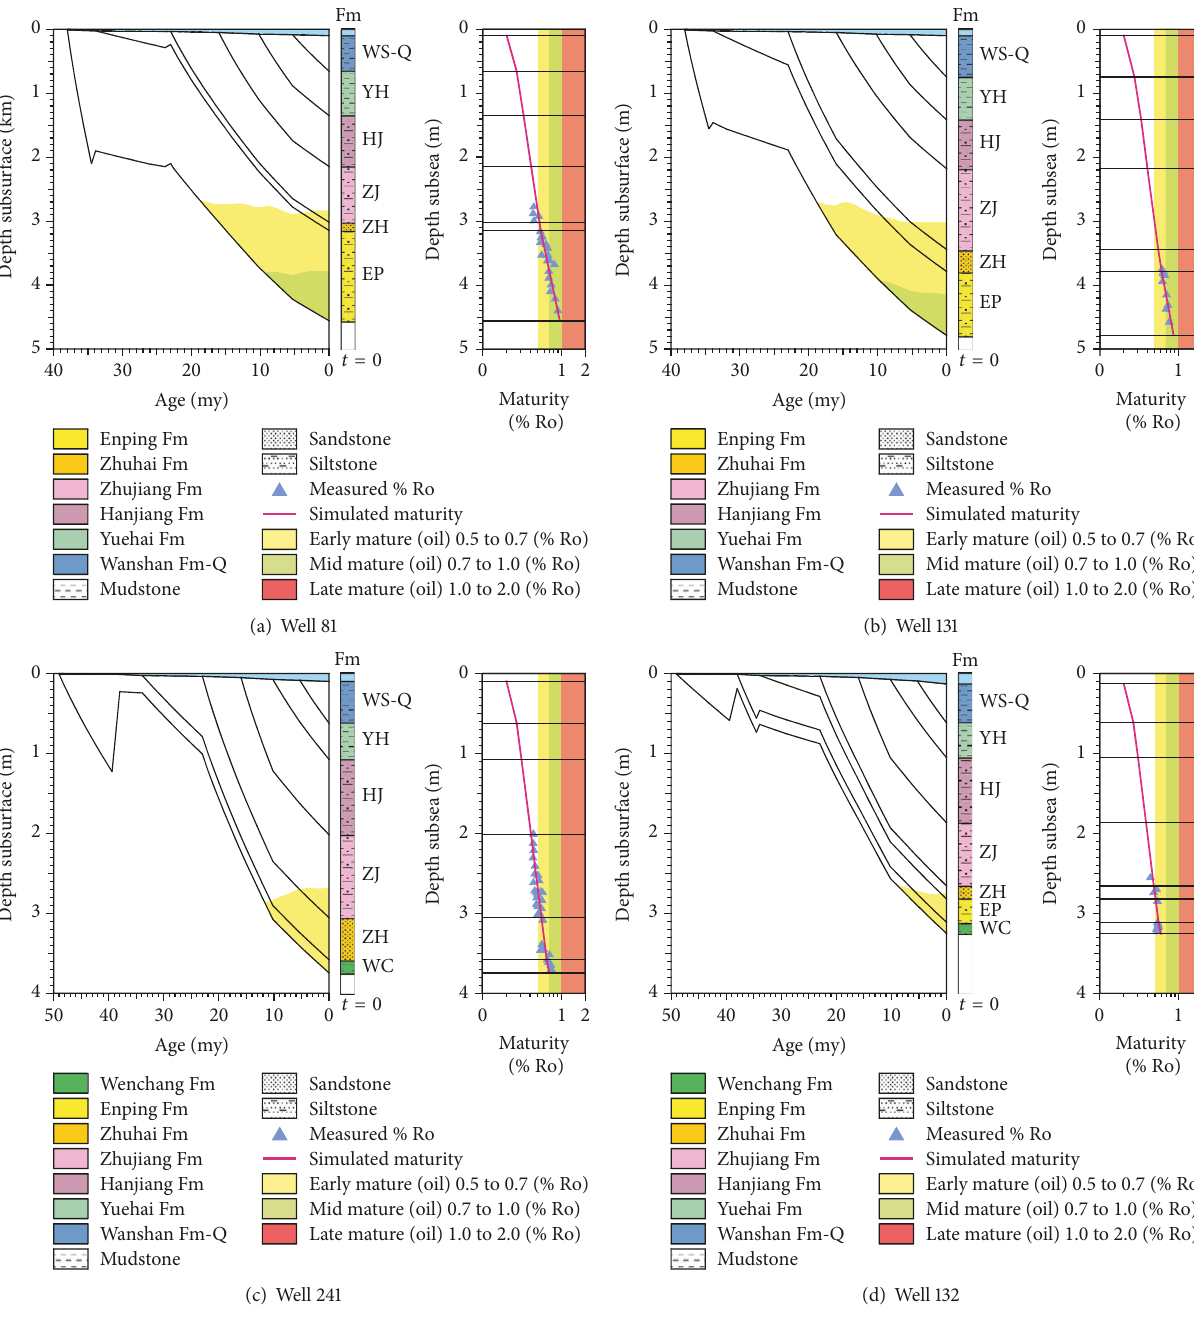
Figure 18: Modeling burial-thermal history calibrated by the measured Ro in the Huizhou Sag (the locations of four wells are shown in Figure 1). Formation names: WC = the Eocene Wenchang Formation; EP = the Eocene Enping Formation; ZH = the Oligocene Zhuhai Formation; ZJ = the Miocene Zhujiang Formation; HJ = the Miocene Hanjiang Formation; YH = the Miocene Yuehai Formation; WS-Q = the Pliocene Wanshan Formation to